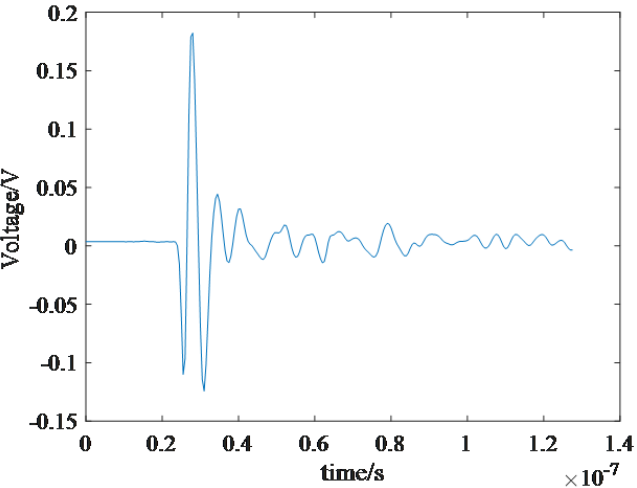
Figure 3. The test result of the second − order Gaussian pulse with some redundant tails, which does not affect the test performance of